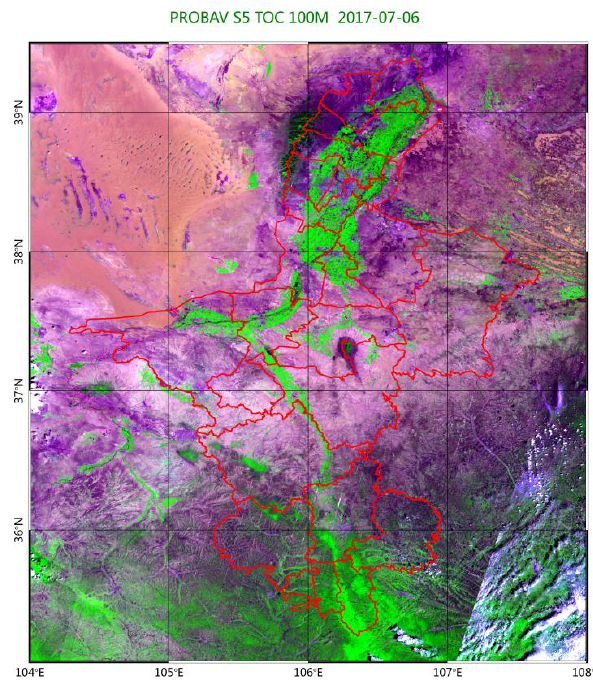
Figure 3. A 100-m PROBA-V image showing the study area, with bands 321 as RGB.